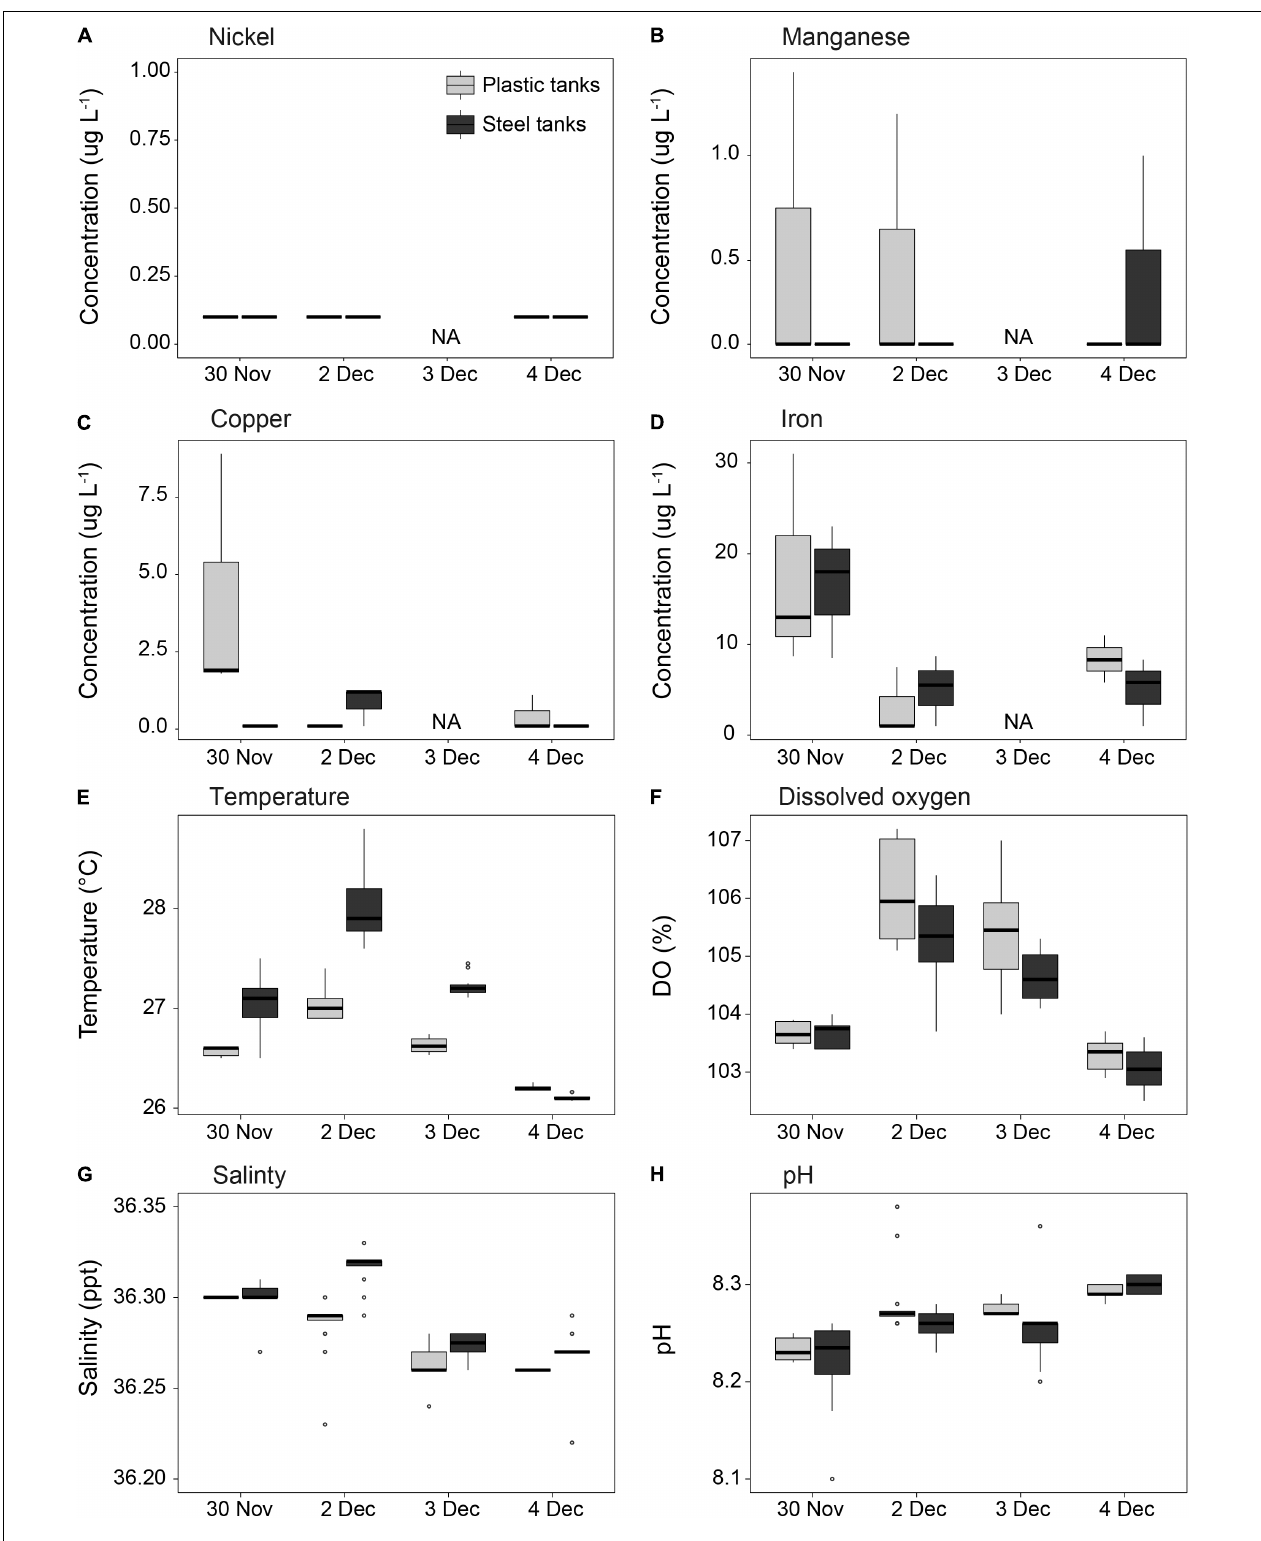
FIGURE 6 | Measurements of (A–D) dissolved metal concentrations and (E–H) water quality in the culture tanks throughout the duration of the coral larvae culturing period. The first batch of spawn slicks were pumped into the culture tanks at 00:30 am on Nov 30. Light gray = plastic tanks; dark gray = steel tanks ( n = 3 per tank type for A–D ; n = 6 per tank type for E–H ; NA = no samples for A–D ).